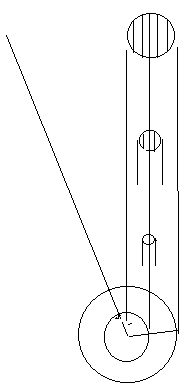
Fig. 1. Influence of parameter “a” on the radius of the danger